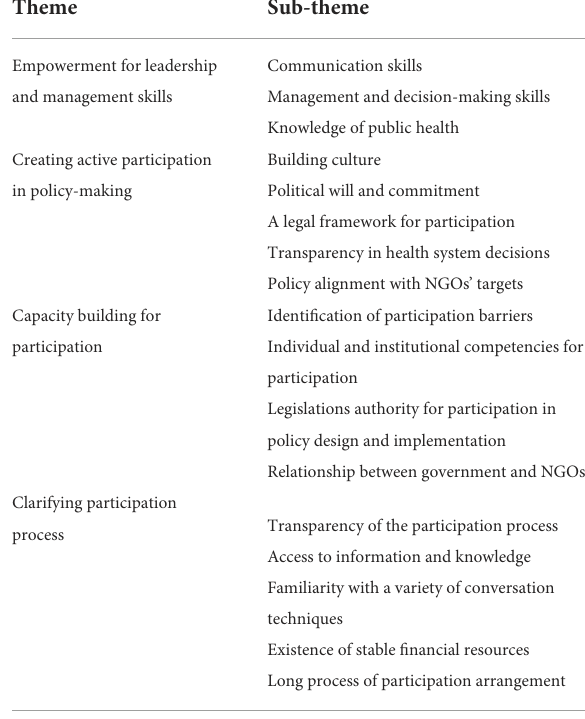
TABLE 1 Theme and sub-themes of strategies to strengthen NGO